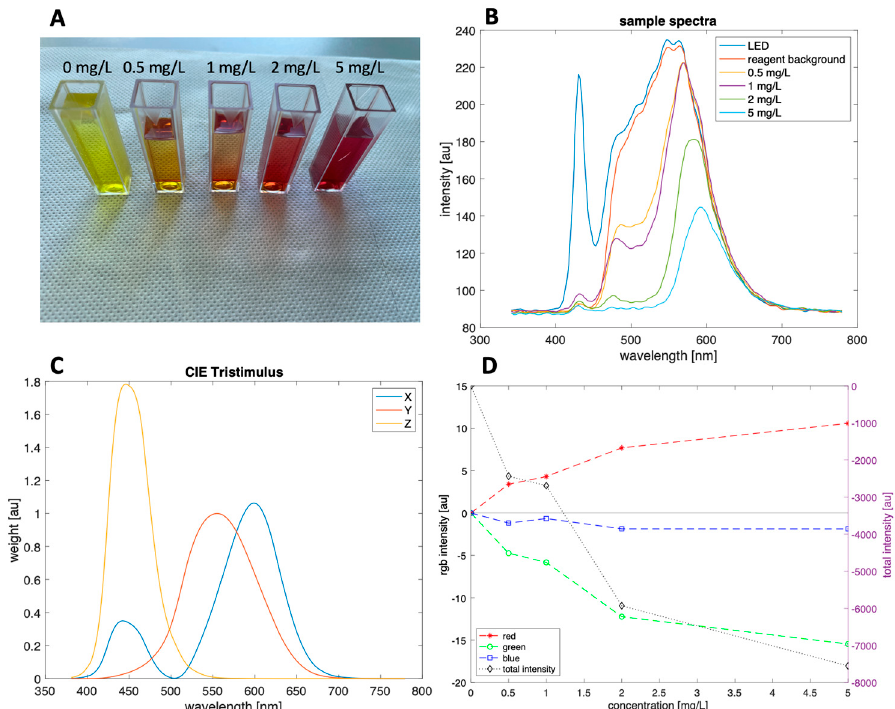
Figure 3. Spectrophotometric characterization of the Griess reaction in the microfluidic chip. ( A ): Griess reaction products at different nitrites concentration. ( B ): spectra collected by the C12666MA spectrophotometer. The white LED spectrum is labelled as water and corresponds to the chip filled with tap water. ( C ): spectral behaviour of the weights of the CIE colour functions. ( D ): calculated red, green, and blue signals normalized respect to the value at 0 mg/L. In this plot also the variation of the total intensity of light is also shown.